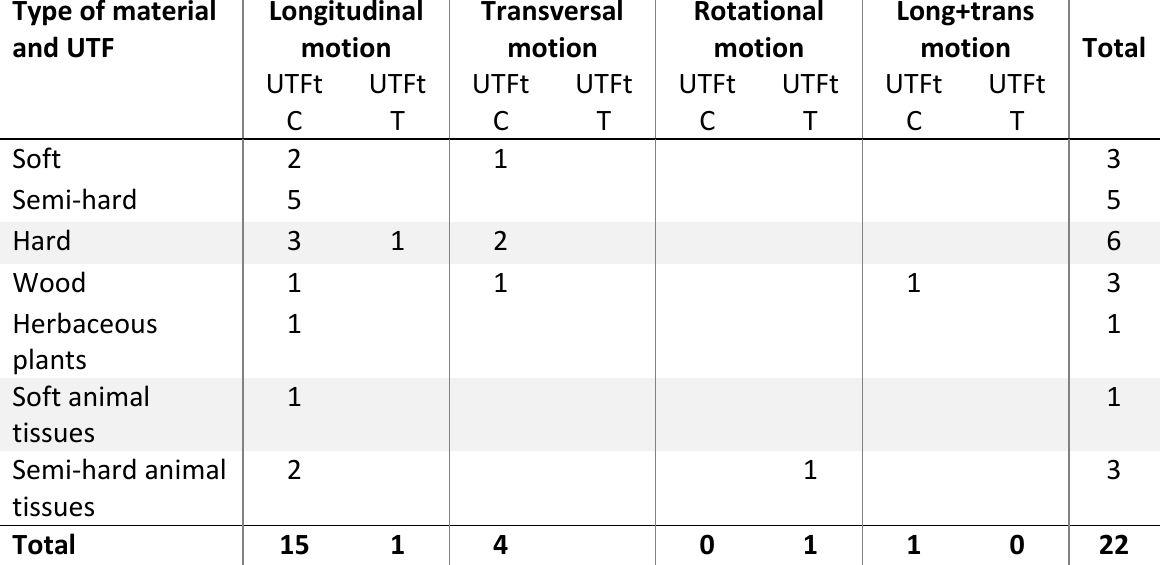
Table 9. Correlation among active parts (UTFt C: cutting edge and UTFt T: trihedron), movement and worked